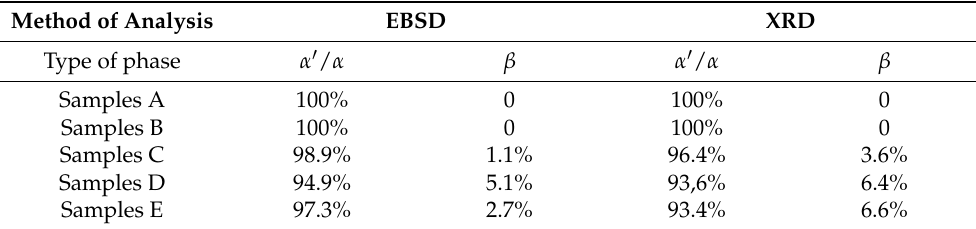
Table 3. The percentage volume fraction of α and β -phases as estimated by EBSD and XRD [7,19]. Method of